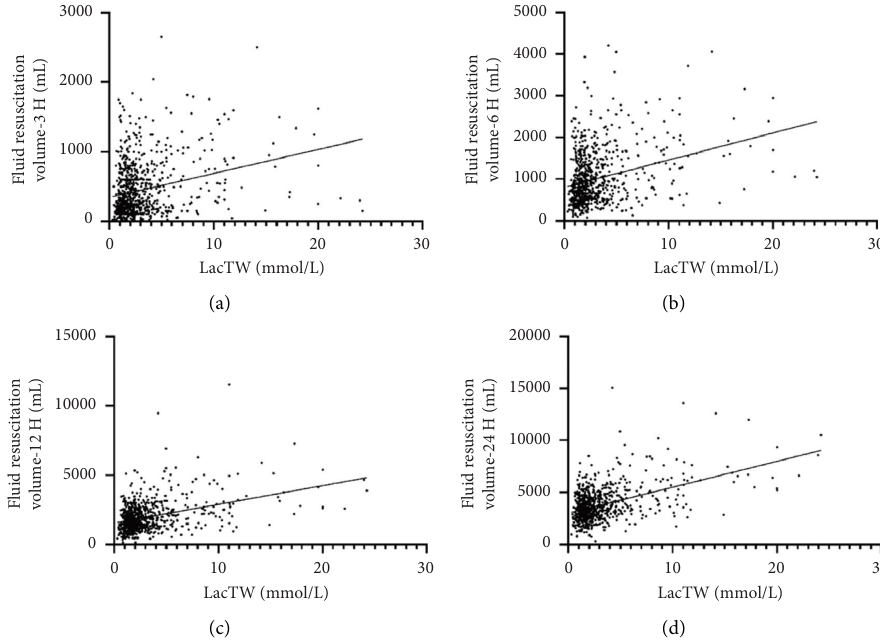
Figure 2: Te linear correlation between LacTW and fuid resuscitation volume. Note. LacTW: time-weighted lactate. (a) Te linear correlation between LacTW and fuid resuscitation volume at 3 hours after ICU admission: positive correlation, R 2 � 0.076, (b) the linear correlation between LacTW and fuid resuscitation volume at 6hours after ICU admission: positive correlation, R 2 � 0.102, (c) the linear correlation between LacTW and fuid resuscitation volume at 12hours after ICU admission: positive correlation, R 2 � 0.157, and (d) the linear correlation between LacTW and fuid resuscitation volume at 24hours after ICU admission: positive correlation, R 2 �